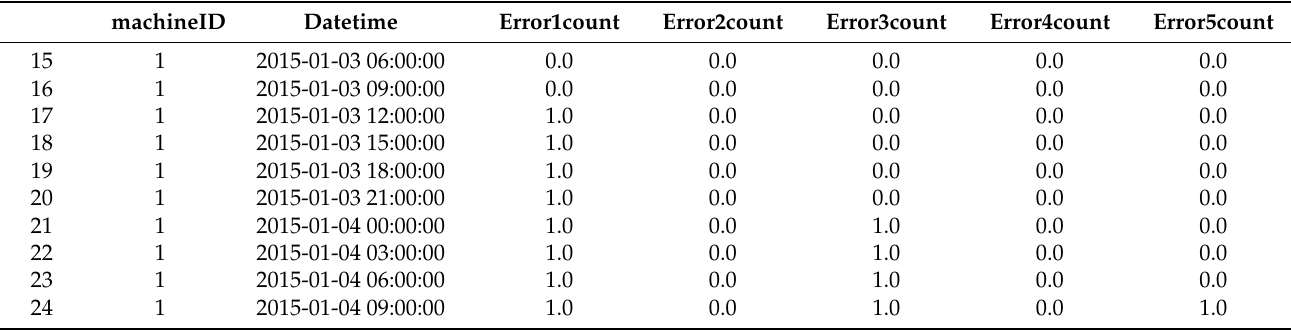
Table 9. Example of Lag Features for error